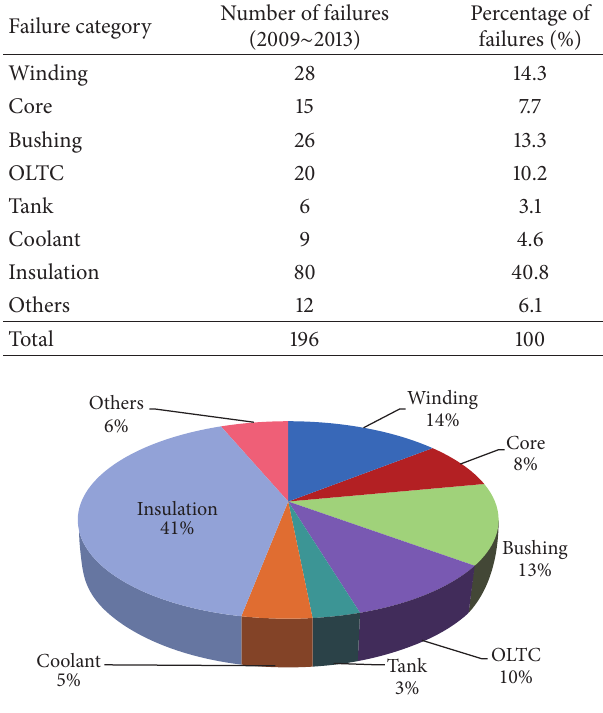
Figure 5: Failure statistics of power transformer component based failures.